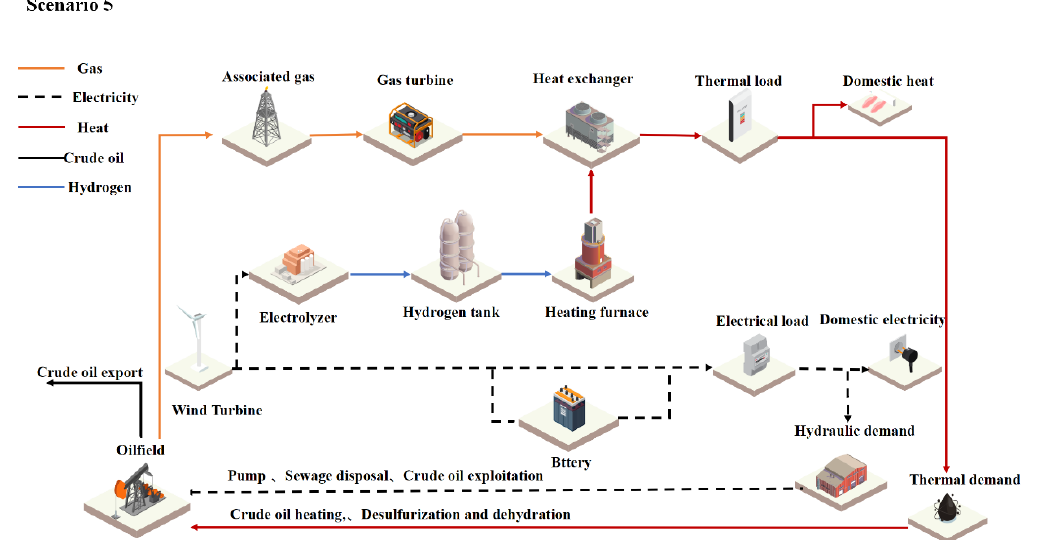
Figure 6. The oilfield energy system framework of scenario 5.